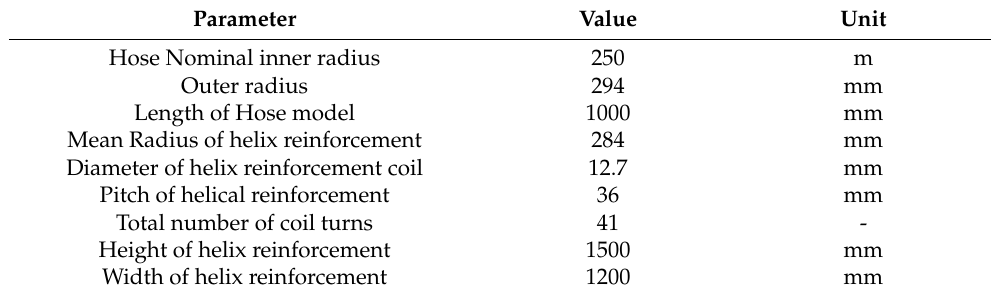
Table 5. Parameters for marine bonded composite hose (MBCH) and helix reinforcement models.